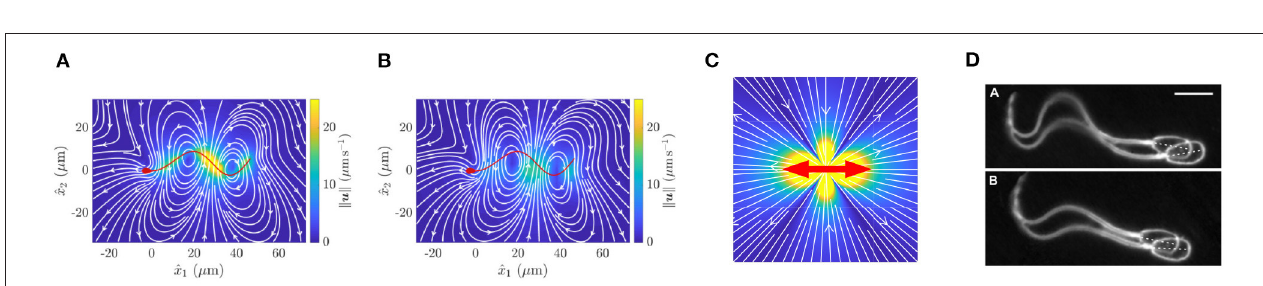
FIGURE 2 | Fluid flow around a virtual spermatozoon, computed via (A) the boundary element method and (B) a coarse-grained model. (C) Flow induced by a point dipole model. The red arrows show the directions of force applied to the fluid, whilst color corresponds to flow velocity. (D) Pairwise swimming of bull spermatozoa. (A,B) reprinted from Walker et al. (2019b), Copyright (2019) by the American Physical Society. (D) republished with permission of the Company of Biologists Ltd from Woolley et al. (2009); permission conveyed through the Copyright Clearance Centre.